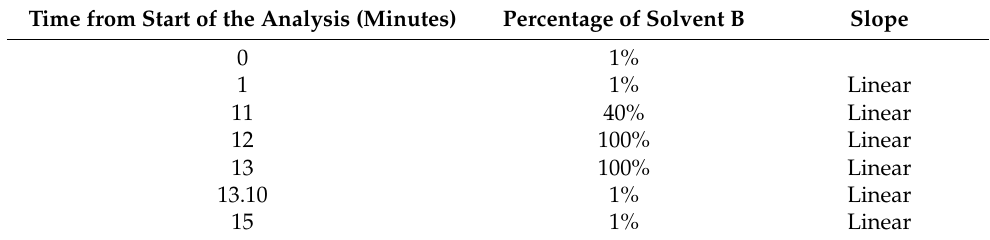
Table 2. Elution of the molecules in UPLC-DAD